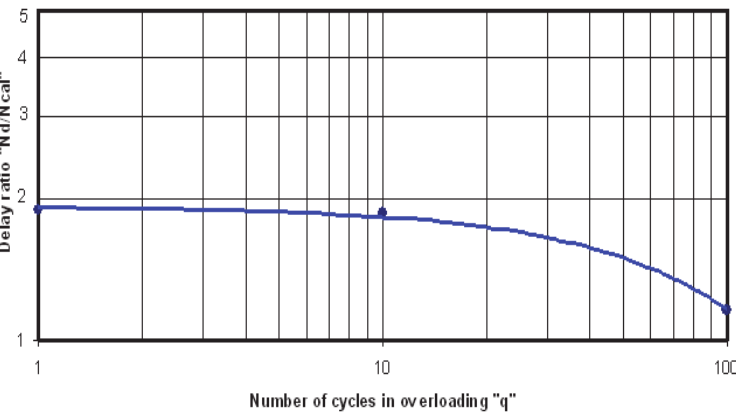
Figure 11. Influence of band overloading parameter “q” on delay ratio N D /N CAL in repaired